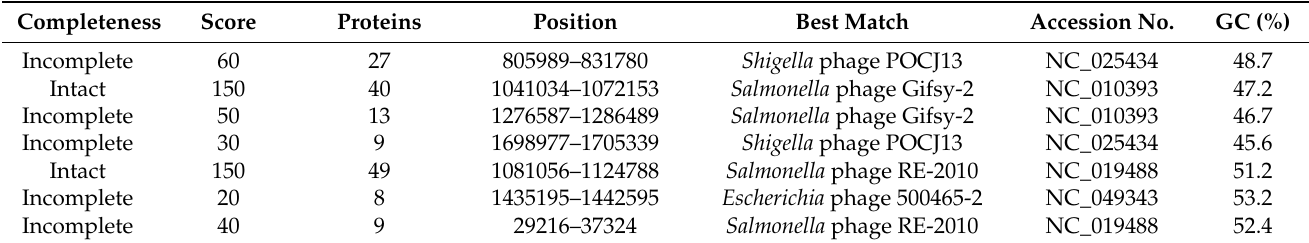
Table 7. Prophage sequences annotated in Salmonella SE3